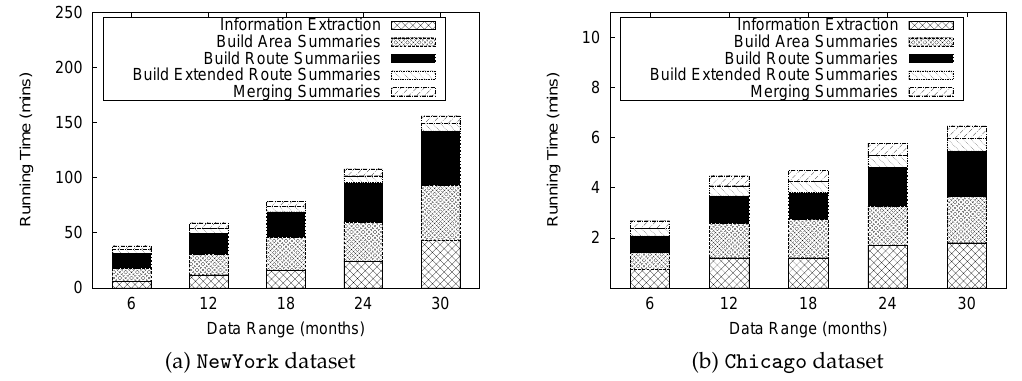
Figure 25. PQ-index construction performance from varying months.